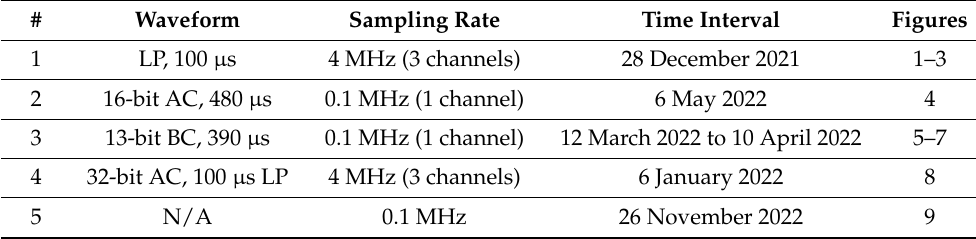
Table 1. Experimental setup of SYISR observations used in the figures. LP: long pulse; AC: alternating code; BC: Barker